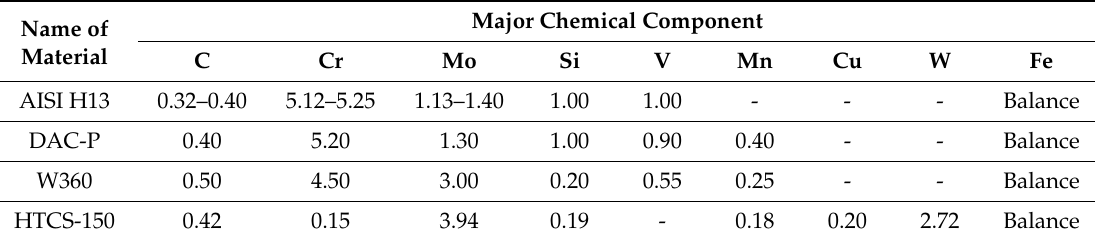
Table 1. Chemical composition of hot work tool steels (wt.%).